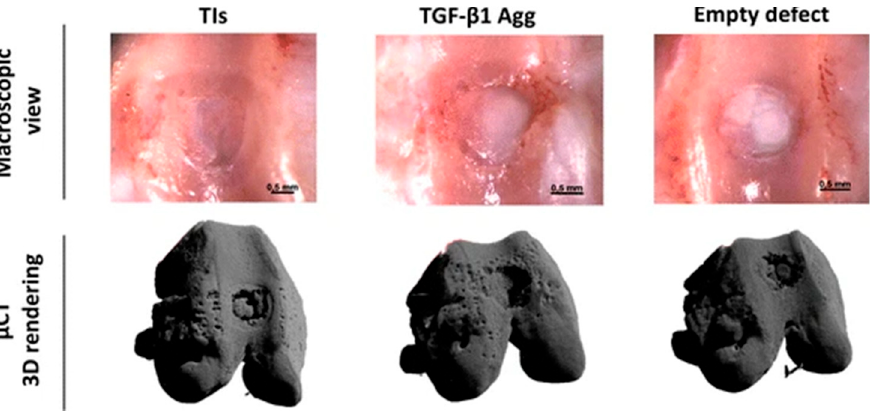
Figure 2. Figure demonstrating how μ CT can be used to monitor healing of critical-sized osteochon- dral defects filled with tissue intermediates (TIs) or transforming growth factor (TGF)- β 1 aggregates (Agg) of human periosteum-derived progenitor cells. Adapted under a Creative Commons CC BY license from Mendes LF et al. Stem Cell Res. Ther., 2018; 9 (42) https://doi.org/10.1186/s13287-018- 0787-3